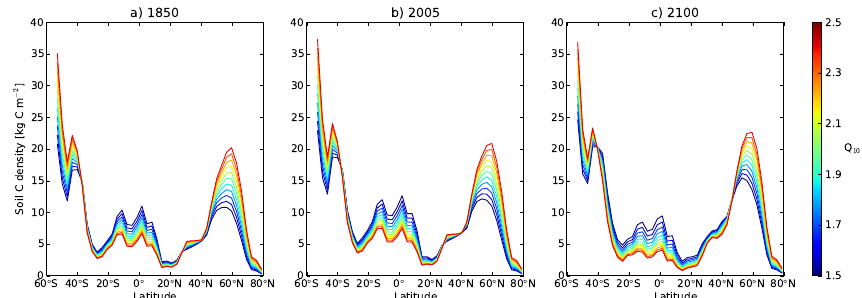
Figure 6. Zonal average soil carbon density in the reduced complexity model with k = 180 months and various values of Q 10 as indicated by the colour bar.